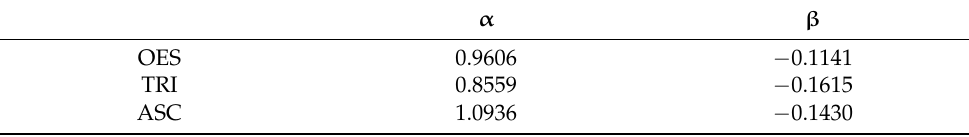
Table 3. Coefficients of correction function, Equation (9), for 0.0025 < Re < 0.02.